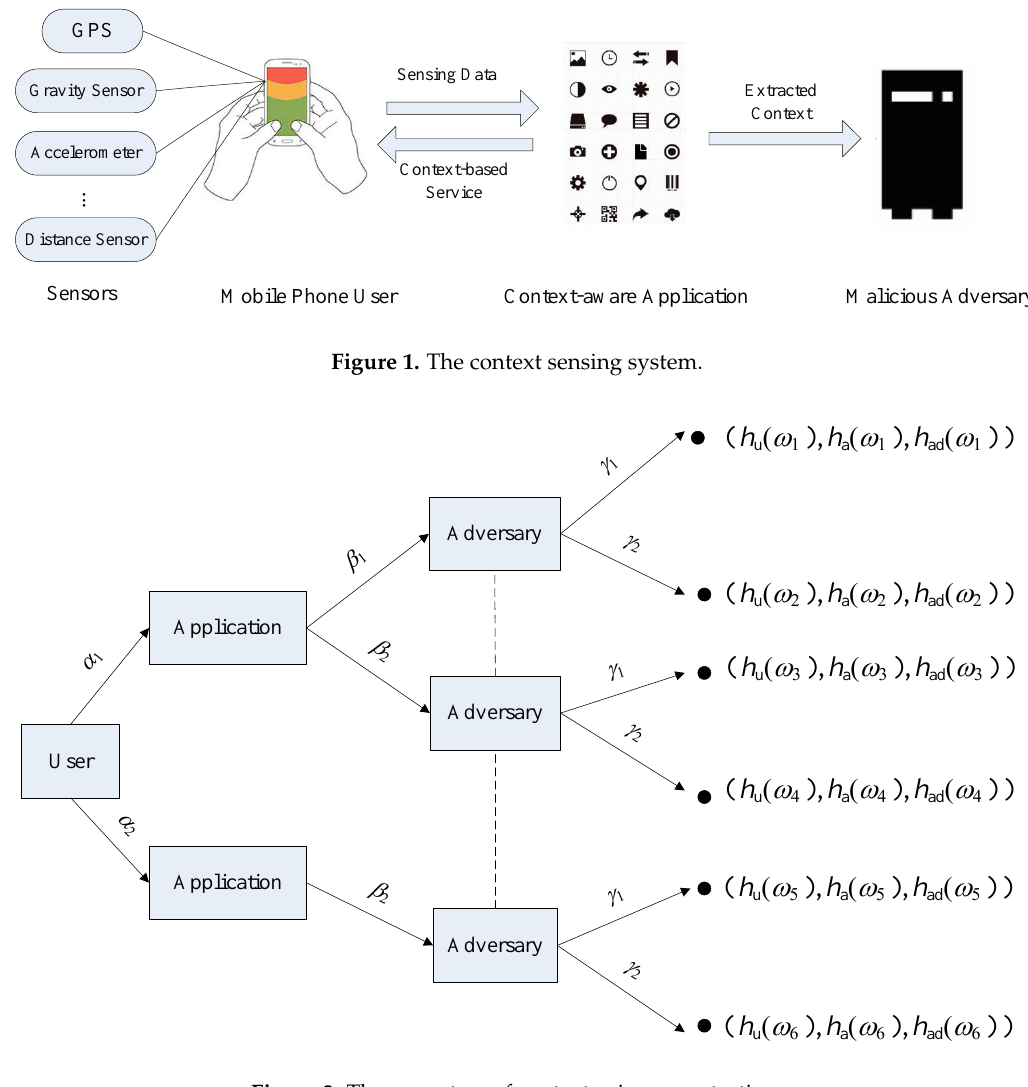
Figure 2. The game tree of context privacy